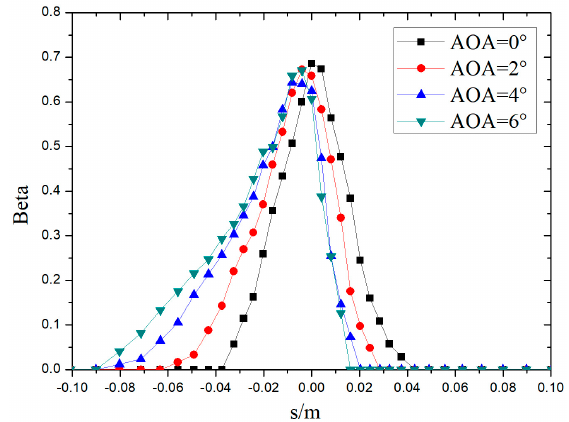
Figure 14. Comparison of ice crystal collection coe ffi cients for di ff erent angles of a tt ack.